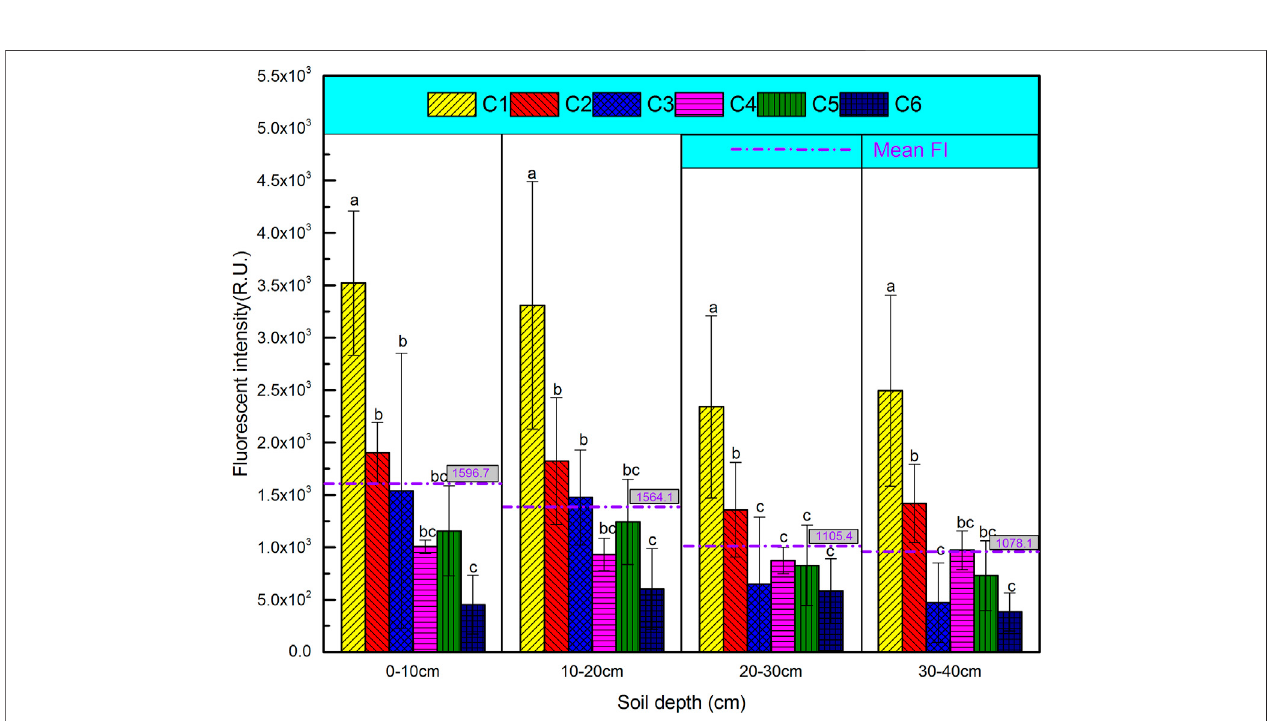
FIGURE 5 | Fluorescent intensities of six fl uorescence components identi fi ed by EEM-PARAFAC modeling in the four soil layers.